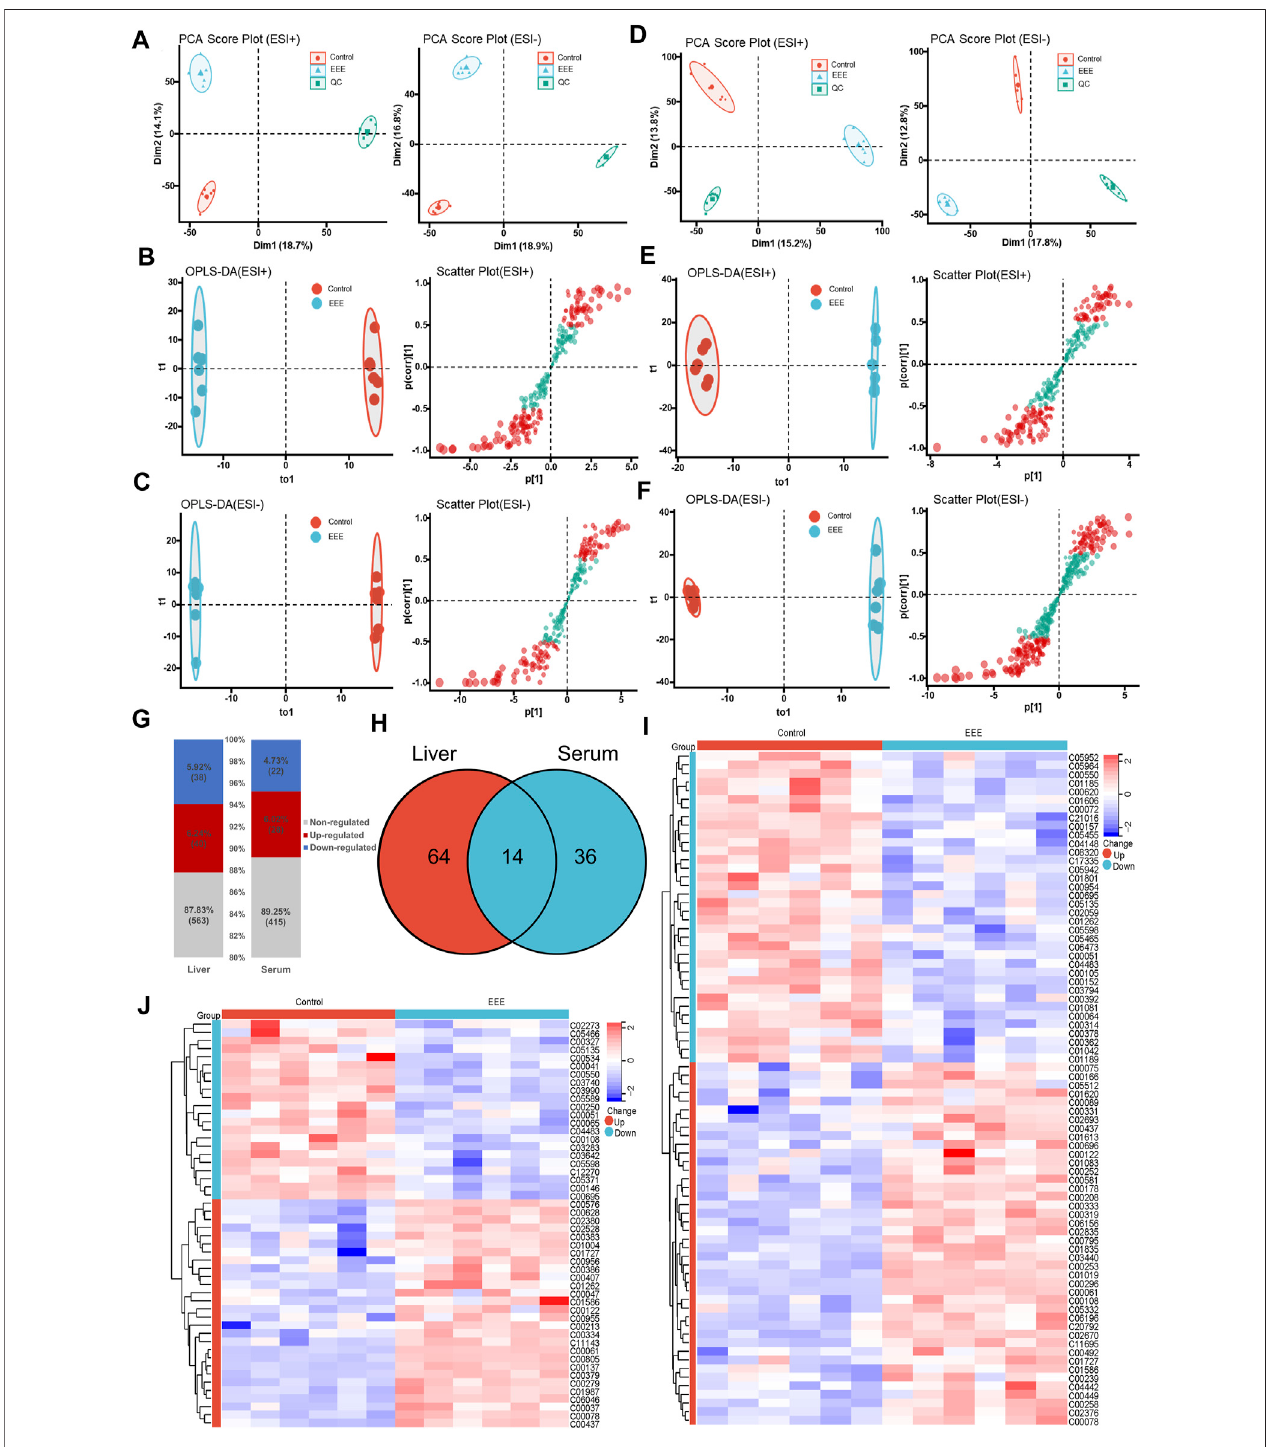
FIGURE3| Metabolomic analysis ofratsafter EEE exposure. (A – C) Metabolomic analysisofrat livertissues.PCA scores (A) , OPLS-DA scores (B) , and S-plot (C) ofdifferentgroupsinlivertissuesunderpositiveandnegativeESImode. (D – F) Metabolomicanalysisofratserum.PCAscores (D) ,OPLS-DAscores (E) ,andS-plot (F) of differentgroupsinserum withpositiveandnegativeESIpatterns. (G) Liverand serummetabolitepro fi lesbetweennormalandEEErats. (H) Shared anduniqueamounts of liver and serum metabolites were also visualized in the Venn diagram between normal and EEE group rats. (I) Heat map of 78 metabolites signi fi cantly altered in theliver,clusteredinthenormalEEEgroup.Thecolorsfrombluetoredindicatetherelativeamountsofmetabolites. (J) Heatmapof50metabolitessigni fi cantlyalteredin serum, clustered in the normal, EEE group. The colors from blue to red indicate the relative content of metabolites.